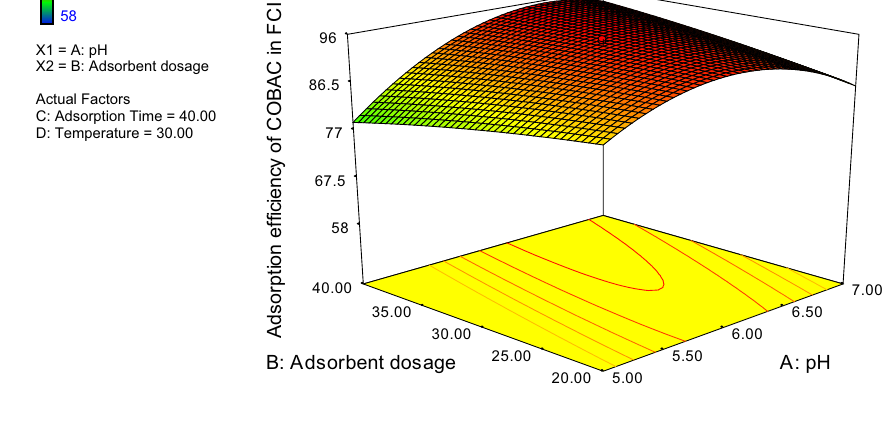
Fig. 4 Contour plot showing the effect of pH and adsorbent dosage on adsorption